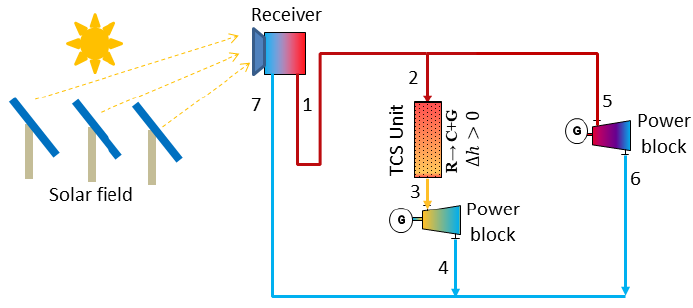
Figure 5. Conceptual scheme of “combined series / parallel” integration between thermochemical storage and power block.